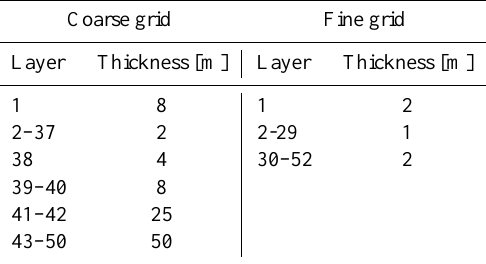
Table 1. Vertical grid